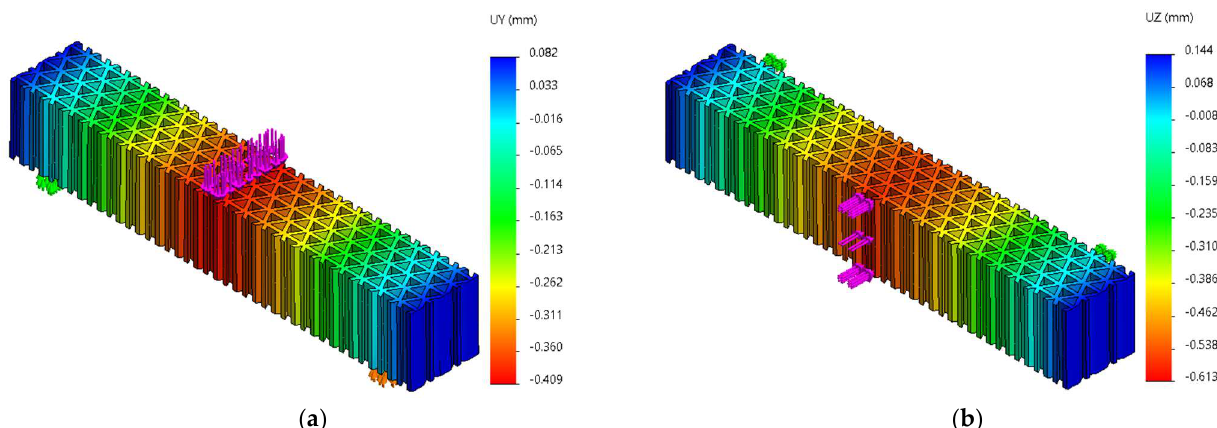
Figure 21. The Uy and Uz displacements charts obtained from FEM analysis of three-point bending of the triangle structure: ( a ) Fy = 70 N, ( b ) Fz = 70 N.